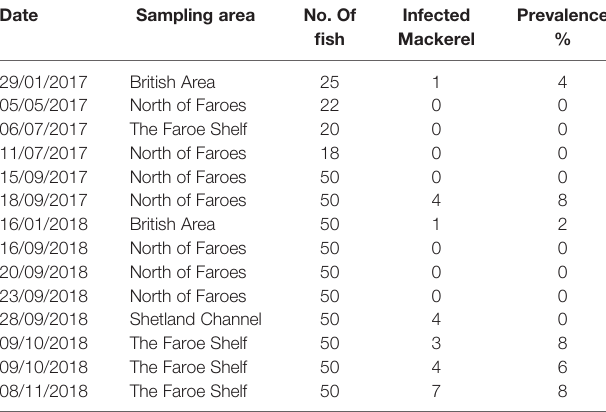
TABLE 1 | Prevalence of Kudoa thyrsites infection in Atlantic mackerel samples collected during 2017 and 2018.